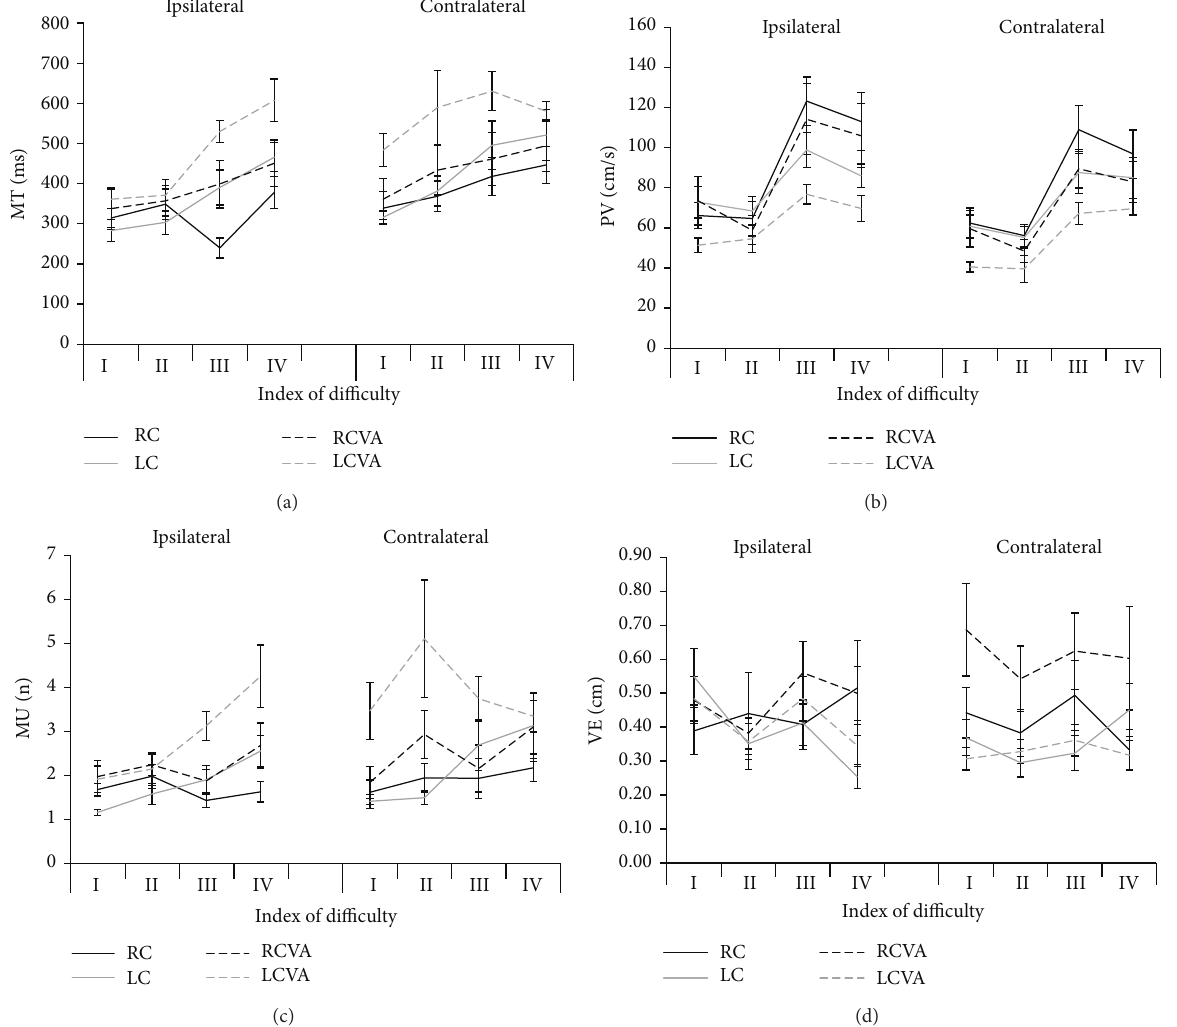
Figure 4: Mean values of movement time (a), peak of velocity (b), movement units (c), and variable error (d) for the right (RC) and left (LC) arms of control group and ipsilesional arms of participants with right (RCVA) and left (LCVA) cerebrovascular accident for ipsilateral and contralateral movements for each index of difficulty ( I = 3.5 ; II = 4.5 ; III = 4.5 ; IV = 5.5) . Bars indicate standard